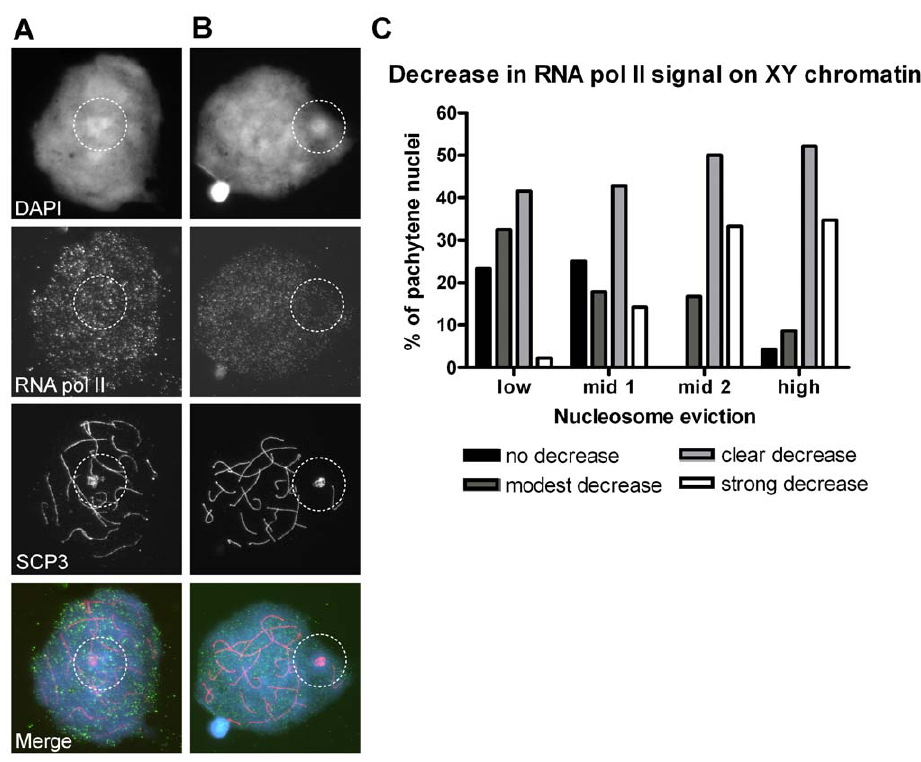
Figure 4. Variation in presence of RNA polymerase II in late pachytene XY bodies. A Late pachytene nucleus, showing no decrease in RNA pol II signal intensity at the XY body compared to the autosomal chromatin. Nuclei were stained with the mouse monoclonal antibody. B Late pachytene nucleus, showing a strong decrease in RNA pol II signal intensity at the XY body compared to the autosomal chromatin. Nuclei were stained with the mouse monoclonal antibody. C Histogram displaying the relation between the degree of nucleosome eviction and the decrease of RNA pol II signal at the XY body, classified into four categories (bars). Total absence of RNA Pol II signal was never observed. Nuclei were stained with the rabbit polyclonal antibody (n=106, P2, C1-3, Table